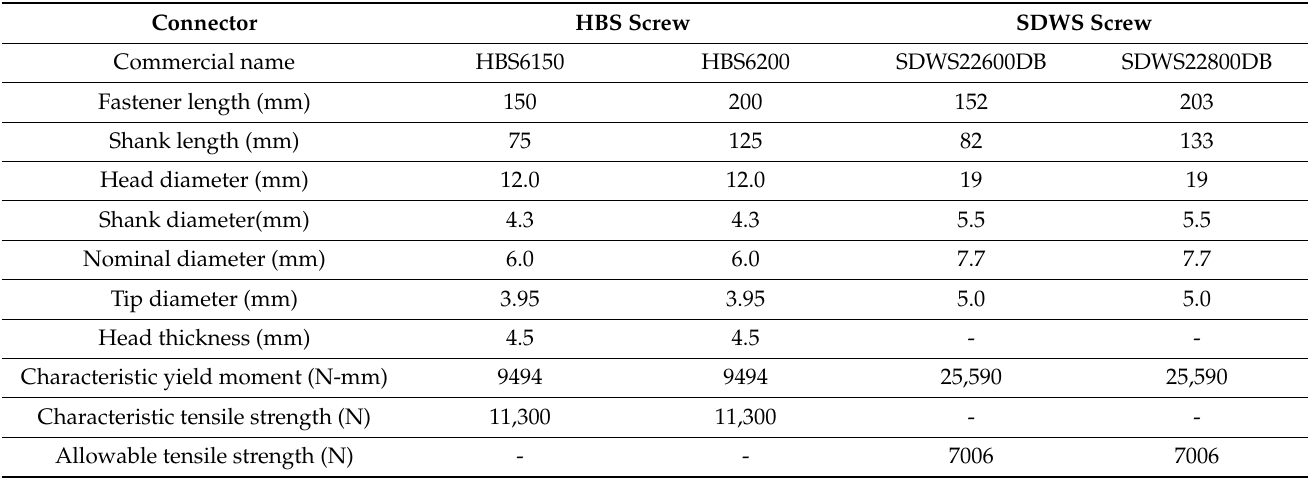
Table 1. Screw geometry and properties.